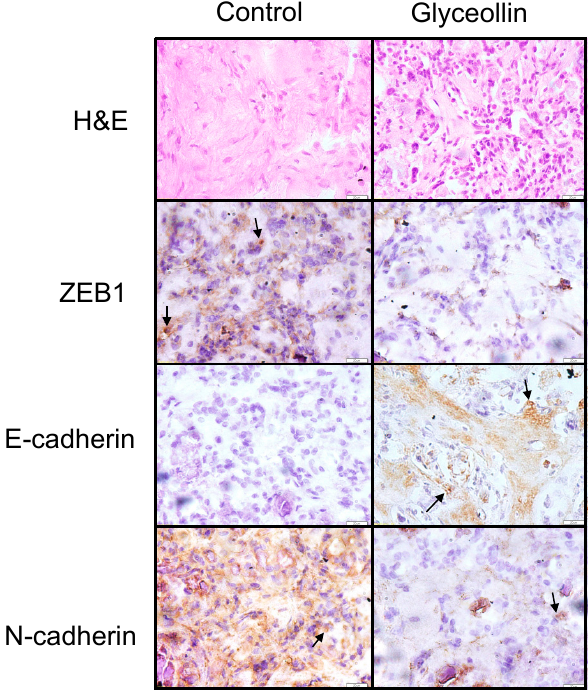
Figure 5. Glyceollin alters EMT Marker Expression in vivo . LTLT-Ca cells were injected into the mammary fat pad of 4–6 week old ovariectomized nude female mice. Mice were given glyceollin i.p. at 20 mg/kg/mouse/d for 40 days starting after tumors were measureable. After 41 days, animals were sacrificed and organs removed for further analysis. Representative sections of tumor sections stained with hematoxylin, anti-ZEB1, anti-E-cadherin and anti-N-cadherin. Left panel represents control-treated tumor sections and right panel represents glyceollin-treated tumor sections. Original magnification, 40 ˆ . Arrows indicate location of positive